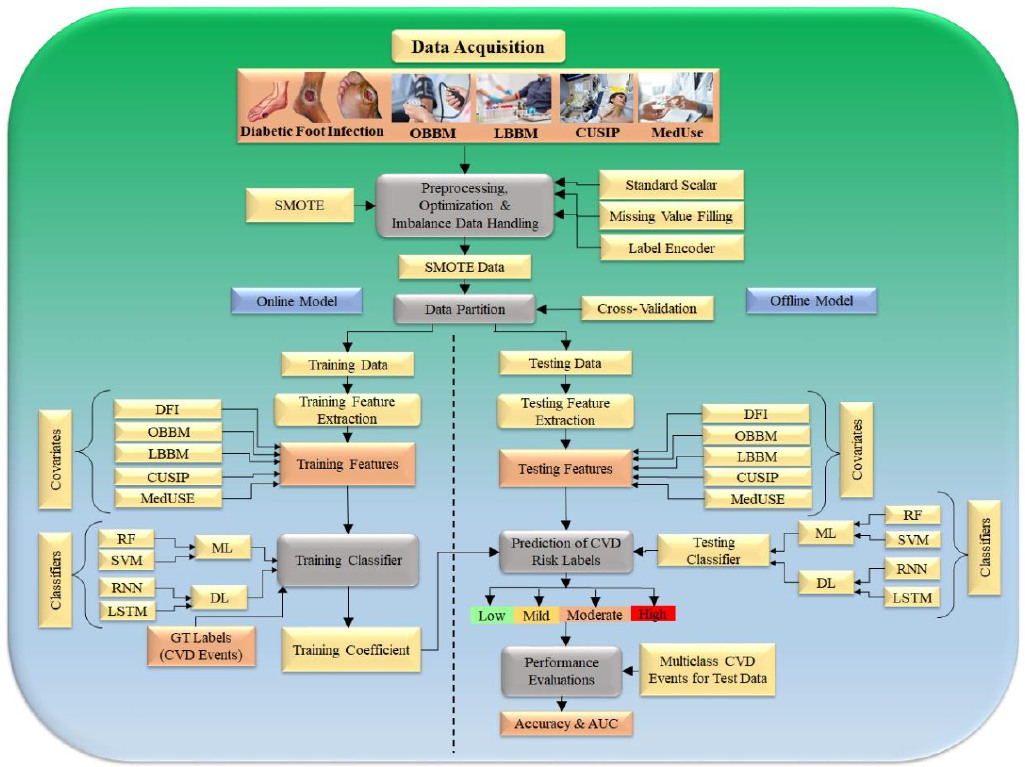
Figure 5. Hybrid model to predict the severity of CVD/Stroke in DFI framework (Courtesy of AtheroPoint™, Roseville, CA, USA permission granted). Table 2. Studies show the role of AI in the diagnosis, and prediction of, DM, DFI, and CVD.